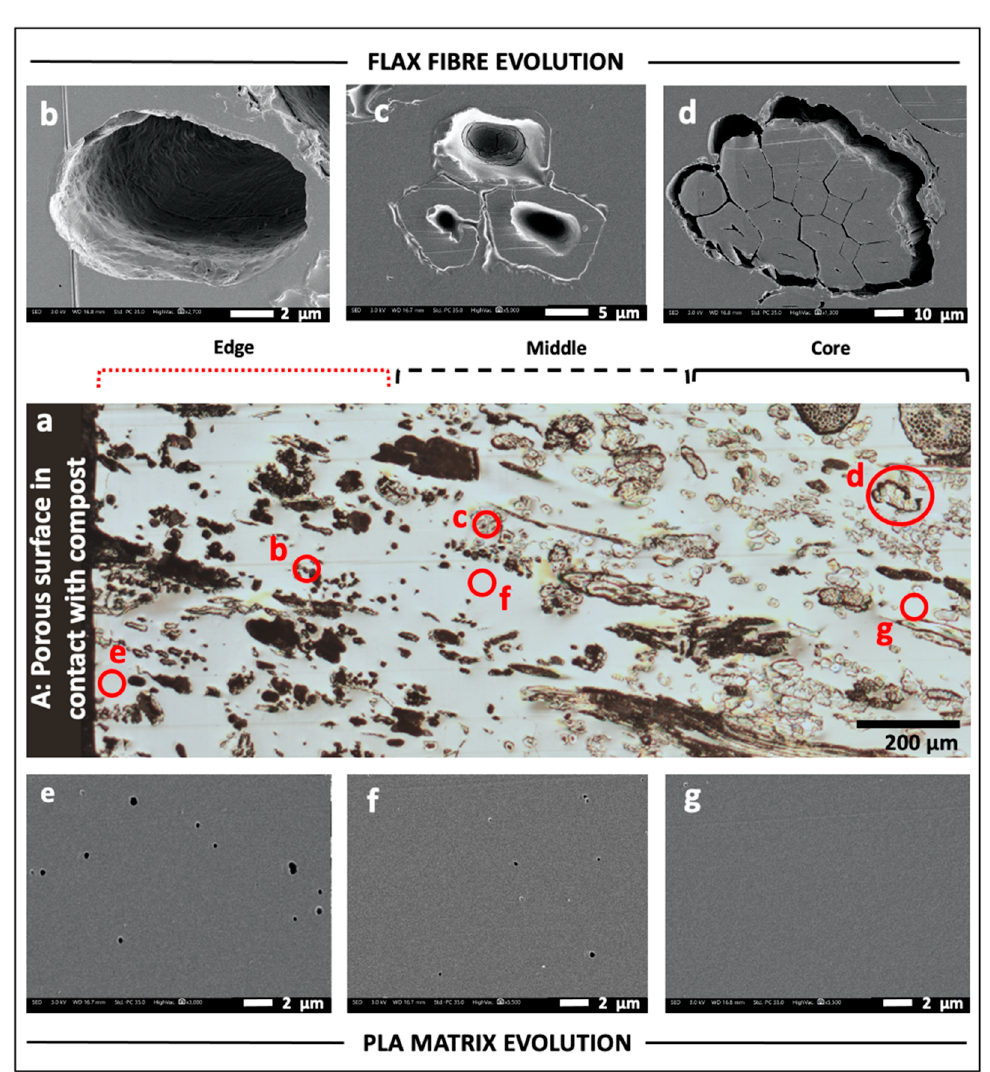
Figure 3. ( a ) Optical micrograph of the investigated face C (see Figure 1), which is divided into edge, middle and core areas following visual observation of fibre degradation; ( b – d ) SEM images of fibres collected in edge, middle and core, respectively. The complete degradation of the fibres leaves phantom cavities with the same shape of the degraded fibre ( b ). Different stages of degradation can be recognised in ( c ). In ( d ), fibres in core appear intact; ( e – f ) SEM images of PLA matrix investigated in edge, middle and core, respectively. Some porosities visible in edge ( e ) and middle ( f ), probably due to degradation, are absent in core ( g ). For each SEM image, the corresponding investigation area is indicated with red circles in ( a